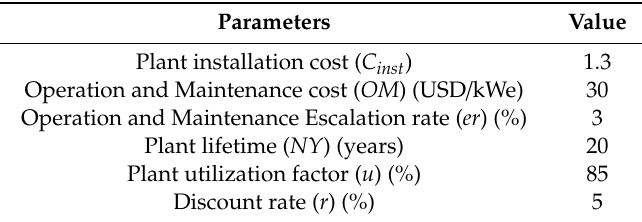
Table 4. Assumptions for economic comparative